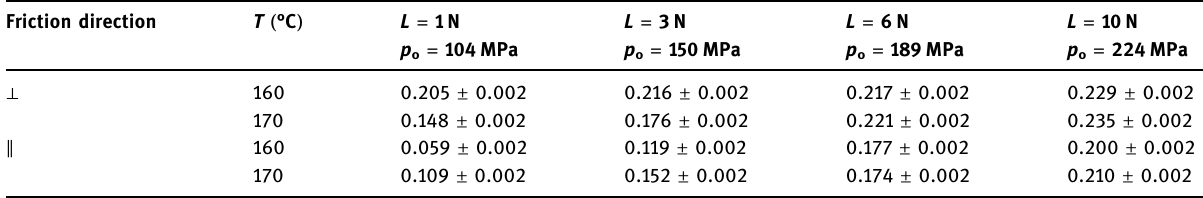
Table 3: Final friction coe ffi cients for Arboblend V2 Nature samples measured at di ff erent applied loads ( L ) with the wear track perpendicular ( ⊥ ) and parallel ( ∥ ) to the surface texture. The mean Hertzian pressure ( p o ) is also